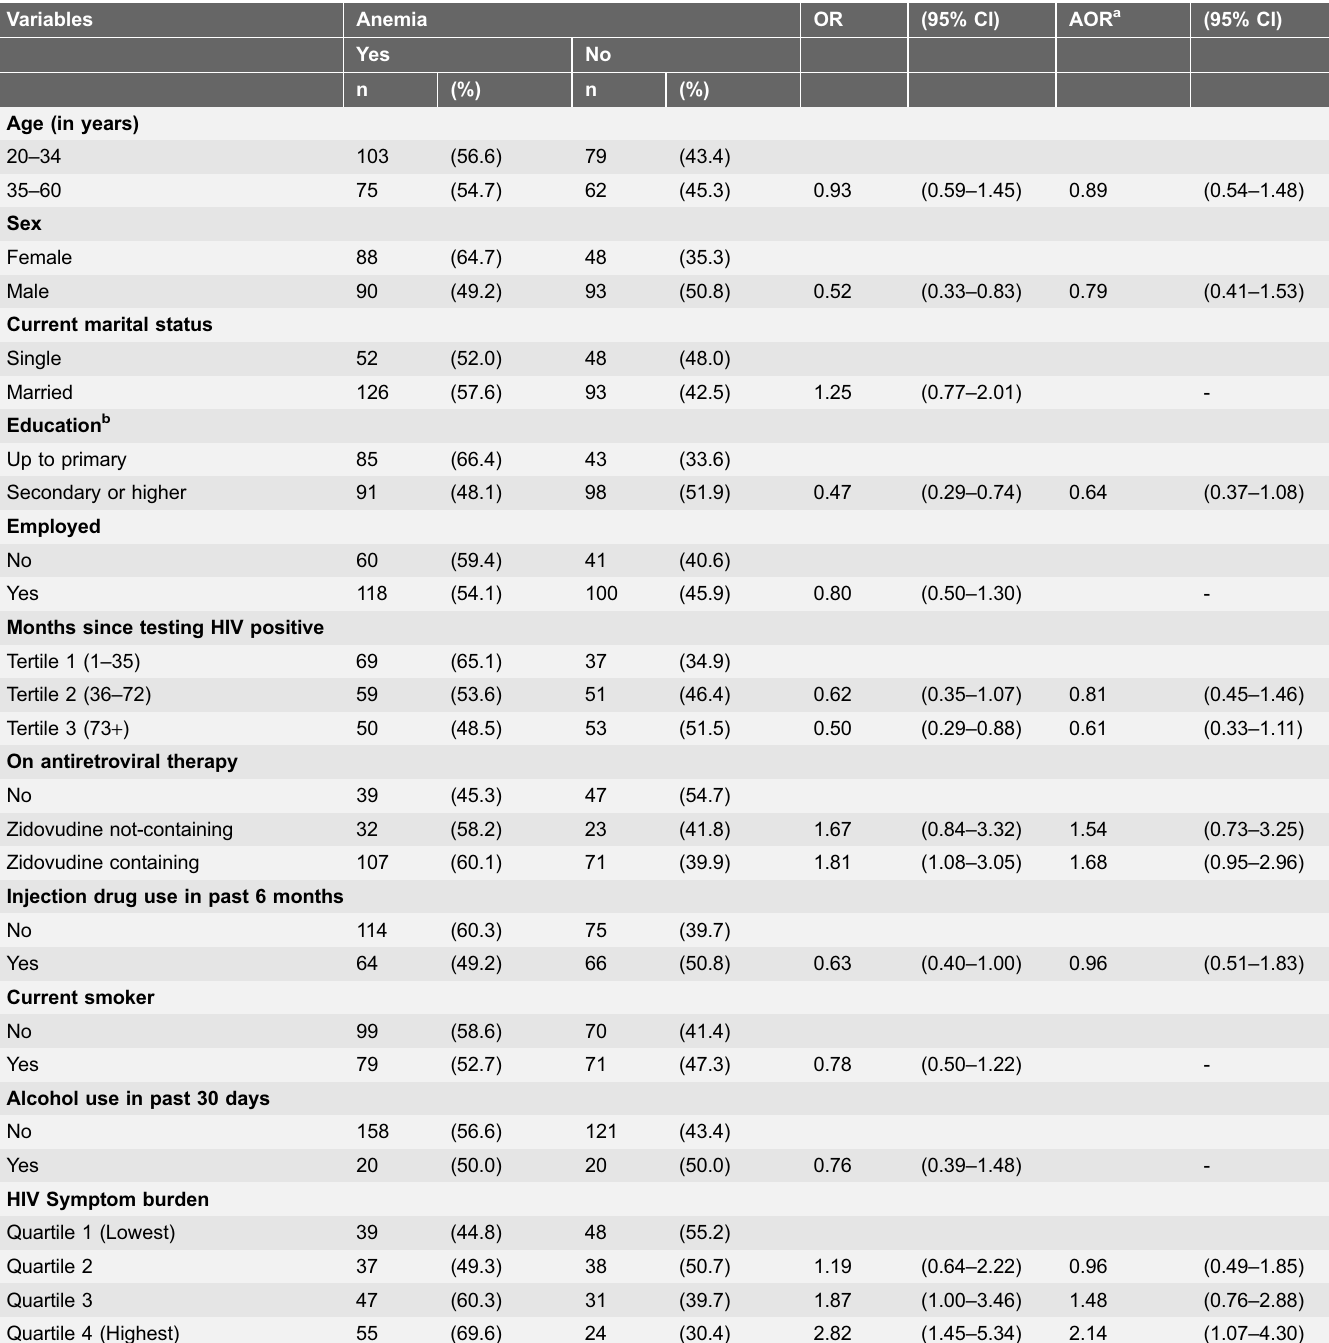
Table 2. Factors associated with anemia among HIV-positive people in the Kathmandu Valley, Nepal.